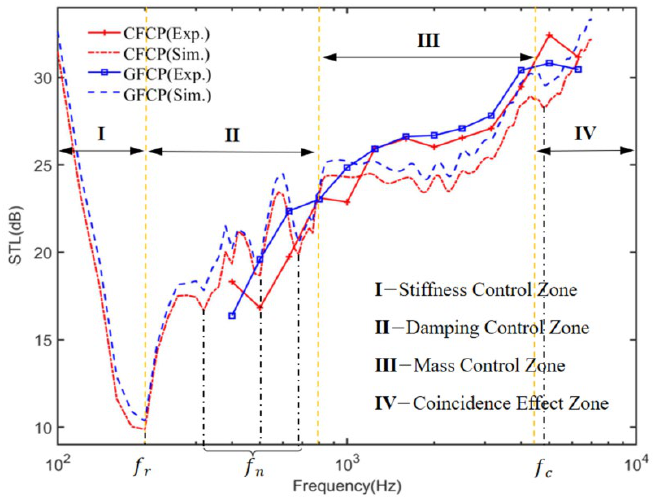
Figure 6. The experimental and numerical results of the STL of different types of corrugated composite panels.